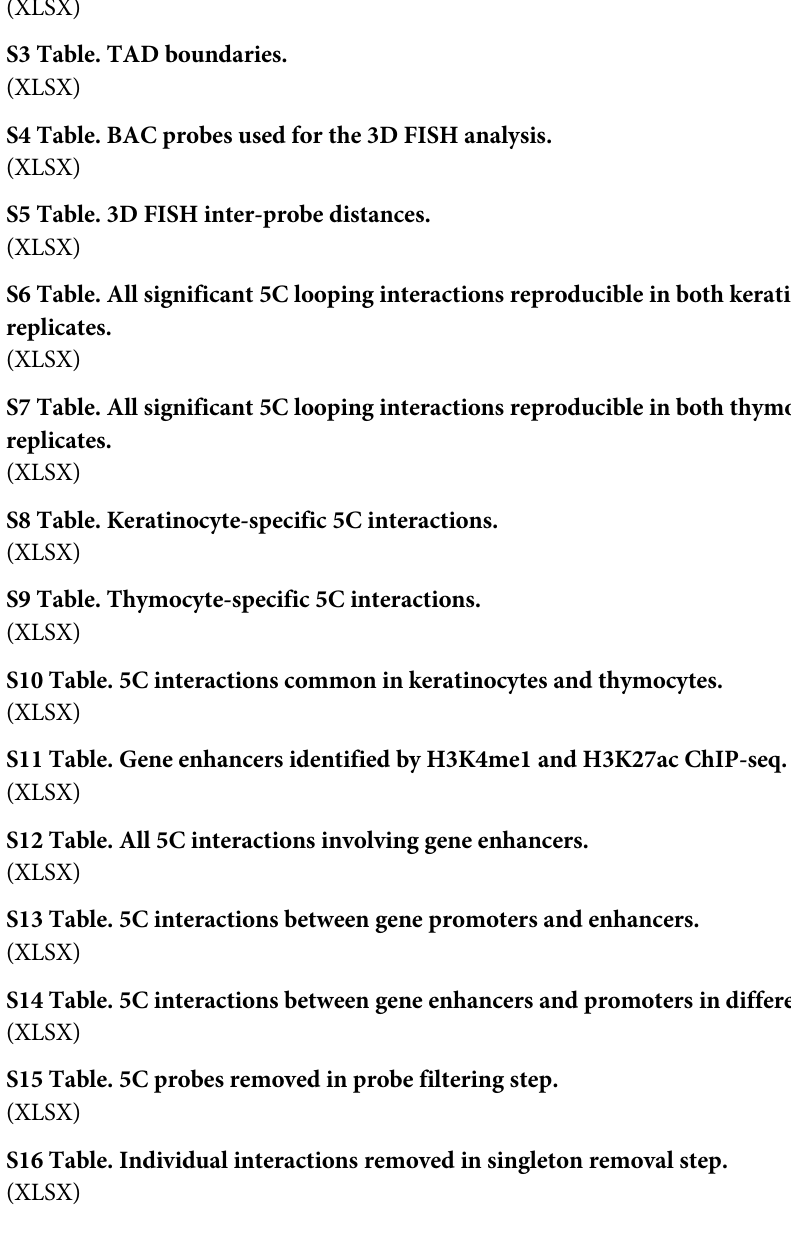
S1 Table. Micro-array expression data in keratinocytes and thymocytes. S2 Table. 5C probe sets. S3 Table. TAD boundaries. S4 Table. BAC probes used for the 3D FISH analysis. S5 Table. 3D FISH inter-probe distances. S6 Table. All significant 5C looping interactions reproducible in both keratinocyte library